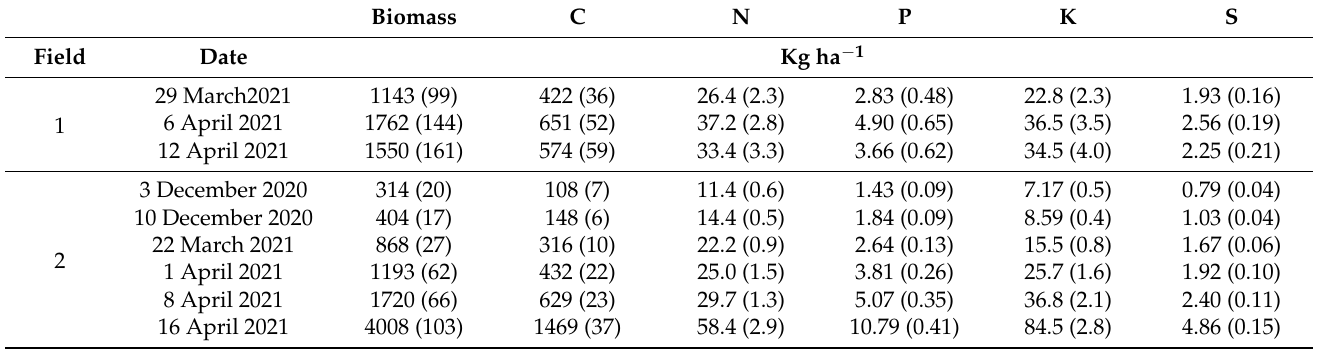
Table 4. Mean (standard error) of content-based in-field cereal rye biomass and nutrient data collected on the date of each UAV